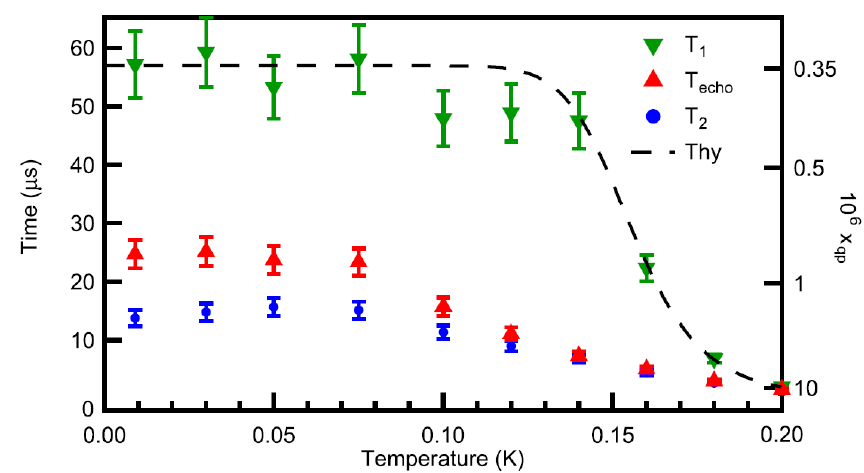
Figure 5: (adapted from Ref. [ 21 ] ) Symbols with error bars: experimental data for T , T , and T vs temperature. Dashed line: theoretical T 1 2 echo Eq.